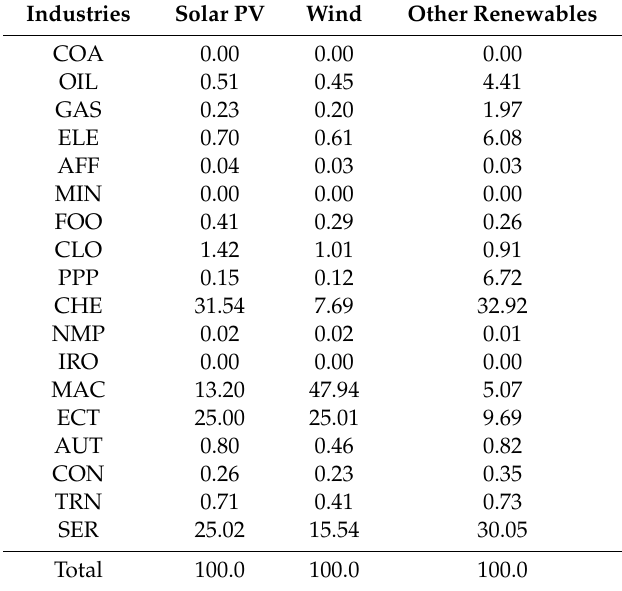
Table 4. Intermediate input structure by renewable energy technology and source (unit: %).